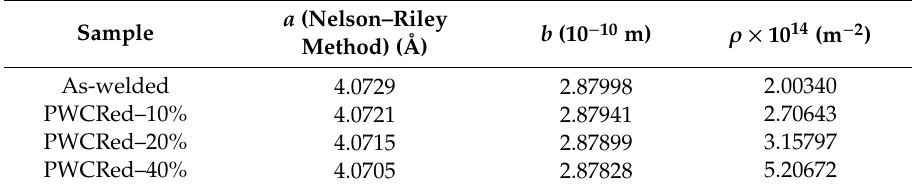
Figure 9. Obtaining lattice parameters of post-weld cold-rolled samples after di ff erent reduction based on the Nelson–Riley function. Table 4. The values of lattice parameter, Burgers vector, and dislocation density of the as-welded and PWCRed